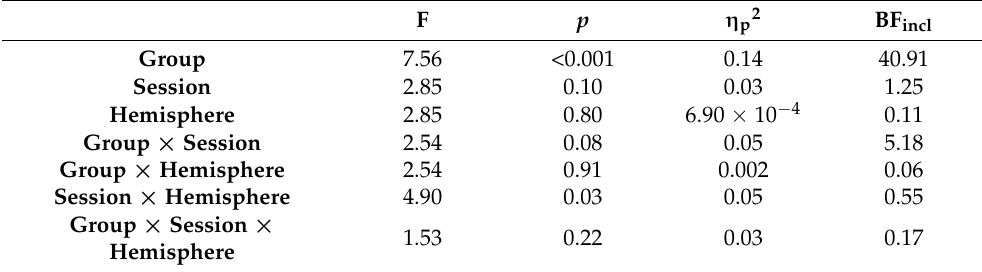
Table 4. Frequentist and Bayesian results from the ANOVA performed on the conflict effect estimated on error rate (%).